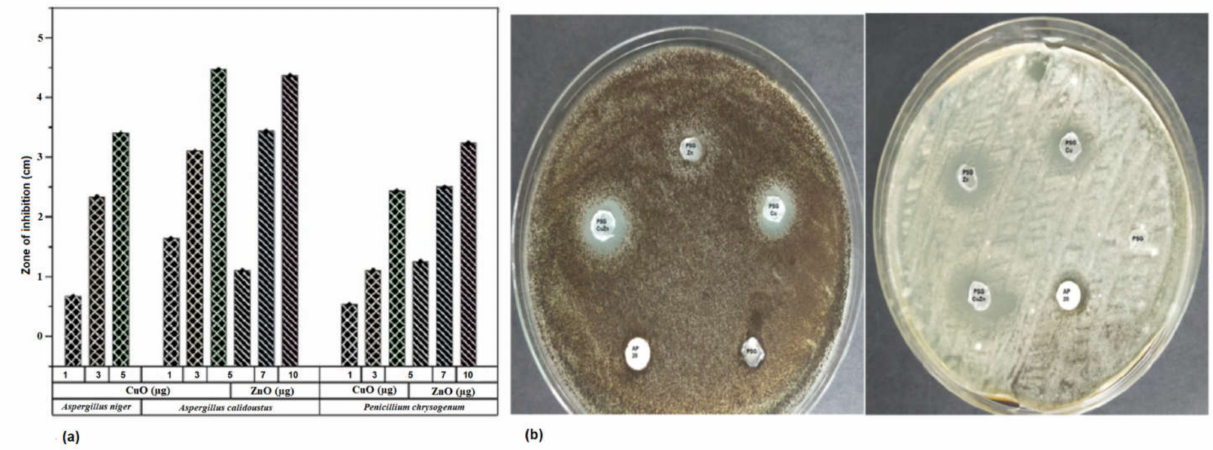
Figure 9. ( a ) ZOI exhibited by of the CuO and ZnO nanoparticles on Aspergillus niger , Aspergillus calidoustus , and Penicillium chrysogenum at the concentration of 1, 3, and 5 µ g of CuO nanoparticles and 5, 7, and 10 µ g of ZnO nanoparticles. ( b ) Antifungal effect of PSG, PSG–Cu, PSG–Zn, PSG–CuZn, and Amphotericin B (20 µ g) on Aspergillus niger and Aspergillus calidoustus